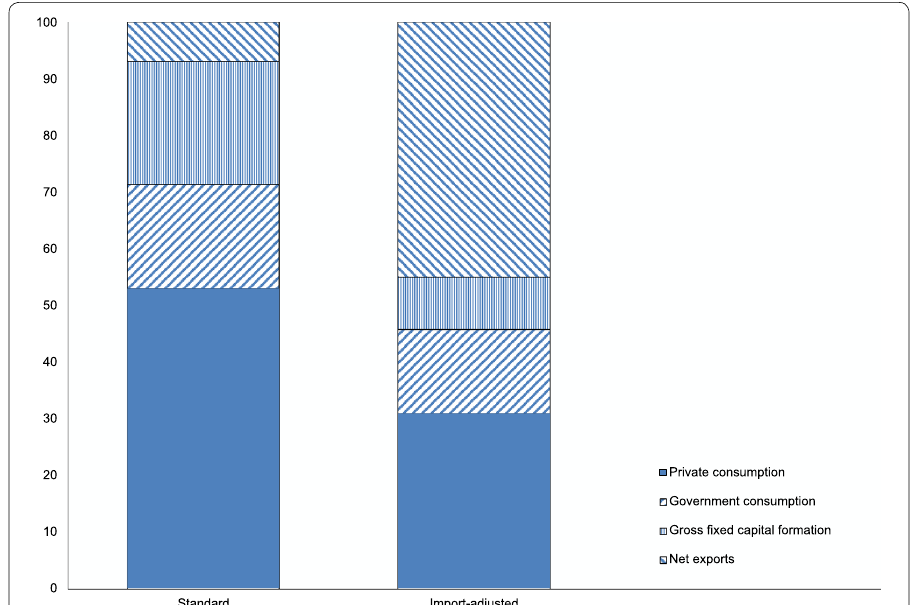
Fig. 3 Relative size of expenditure components expressed as % of nominal GDP estimated as an average between 2008 and 2017